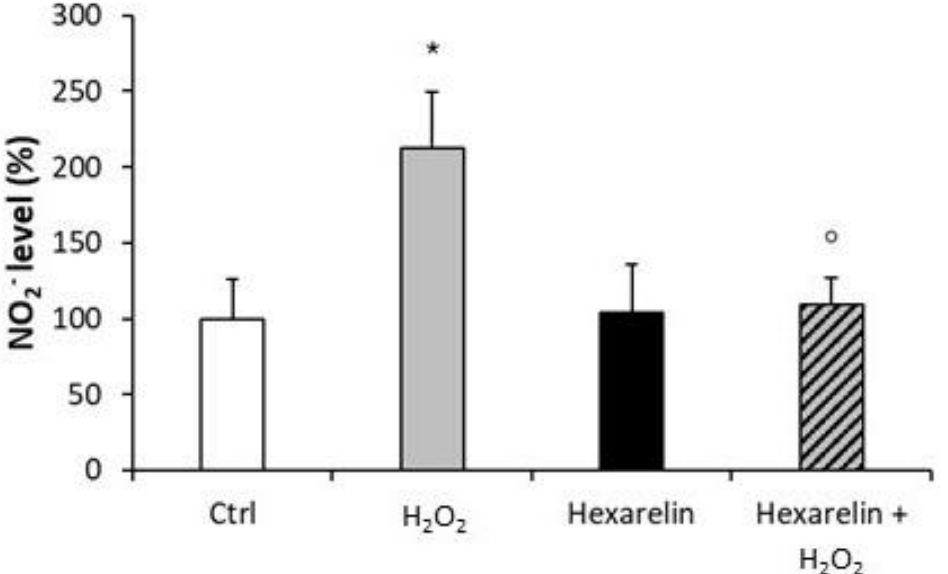
Figure 3. Hexarelin reduced the extracellular NO 2 − release induced by H 2 O 2 . Neuro-2A cells were treated for 24 h with or without hexarelin and 100 µ M H 2 O 2 . The culture media were used for O . The culture media were used for Griess reaction to measure NO 2− extracellular re- 2 2